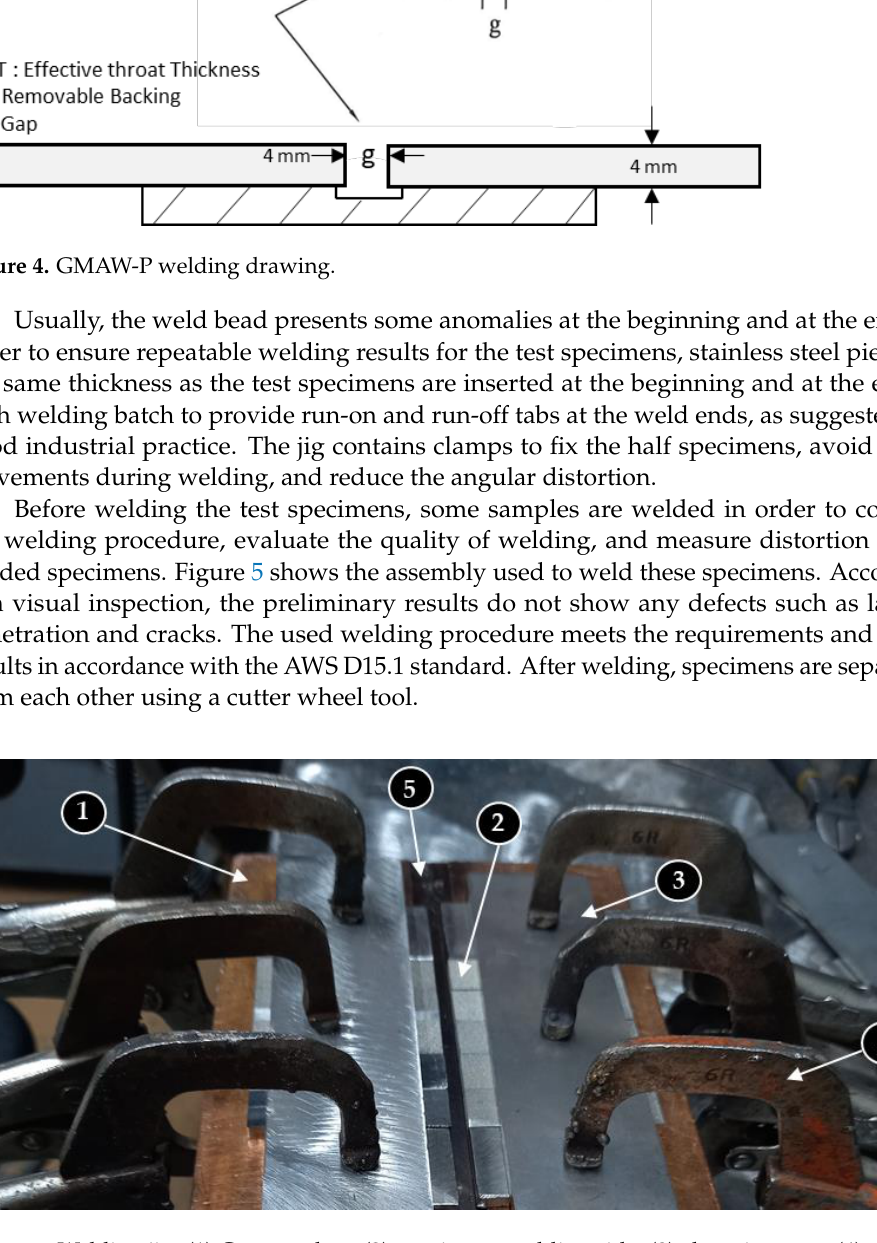
Figure 5. Welding jig: (1) Copper plate, (2) specimens welding side, (3) clamping part, (4) clamps, (5) groove.